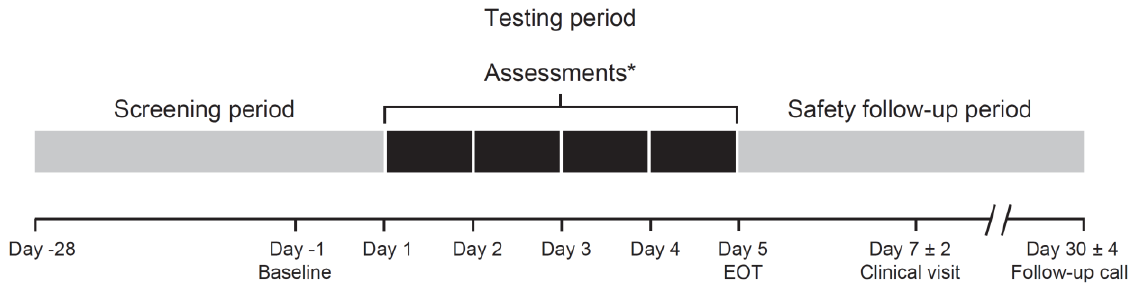
Figure 1. Study design. * Daily testing assessments were divided into 2 parts. In Part 1, participants ( n = 2) assessed pimavanserin 34 mg mixed with 15 mL or 30 mL food vehicle to determine the minimum acceptable volume. In Part 2, participants ( n = 16) assessed pimavanserin 34 mg mixed with the minimum volume of food vehicle determined in Part 1. EOT = end of treatment.